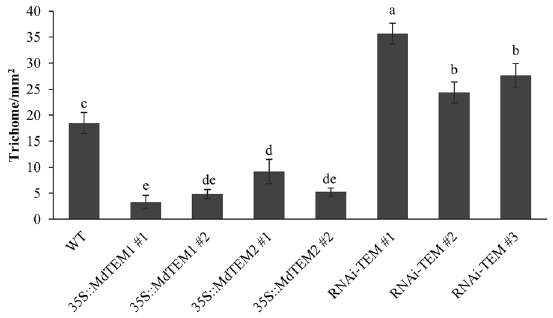
Figure 8. Number of trichomes per mm 2 in different MdTEM overexpressed, silenced and wild type control plants of Fragaria vesca . For each line, a total of 3 slides containing 5 sections each were prepared, making a total of 15 sections per line with three biological replications. Error bars indicated standard errors. Means were compared by LSD test and different letters show a significant difference at p ≤